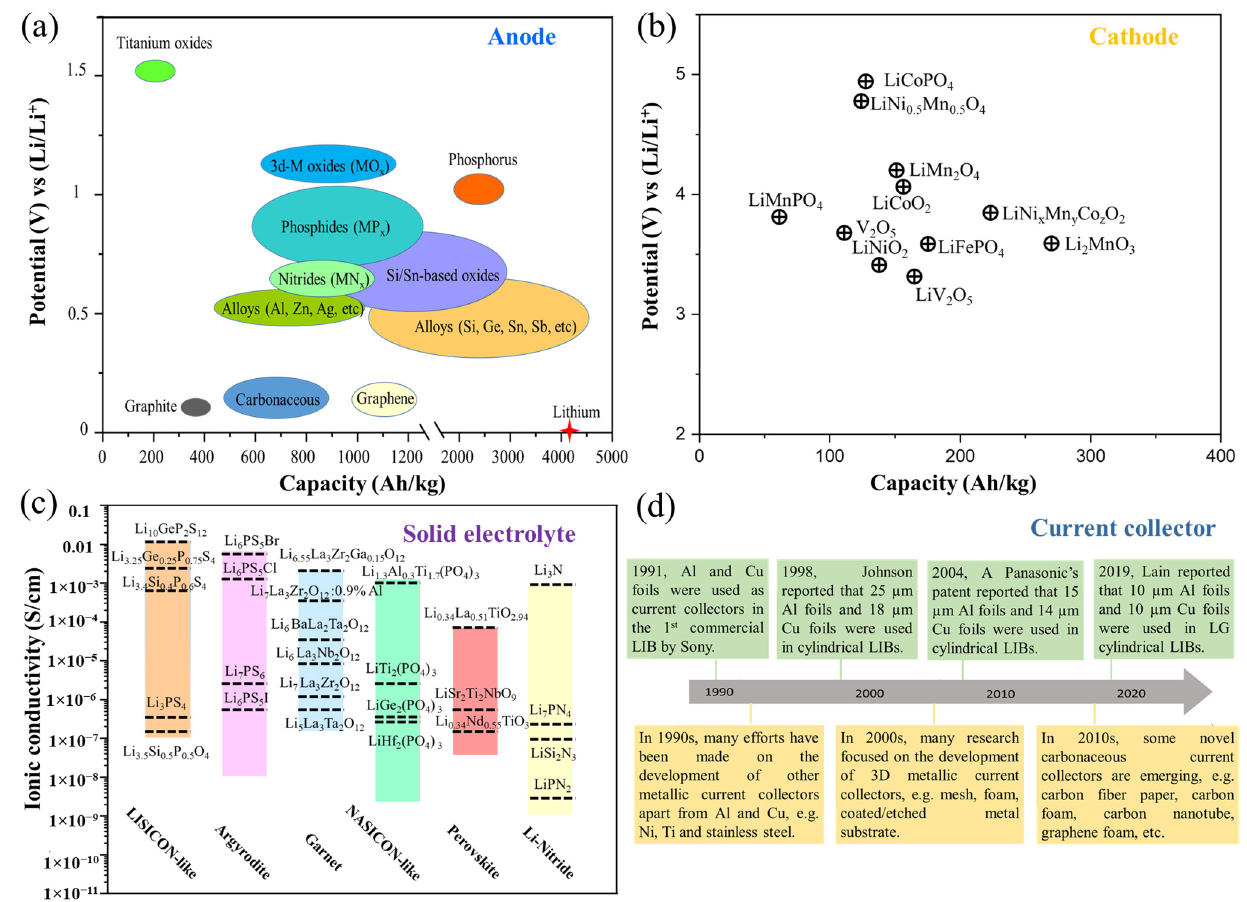
Figure 1. Schematic view of the development of battery materials for TFLIBs: ( a ) Anode materials, ( b ) cathode materials, ( c ) electrolytes, and ( d ) current collectors.